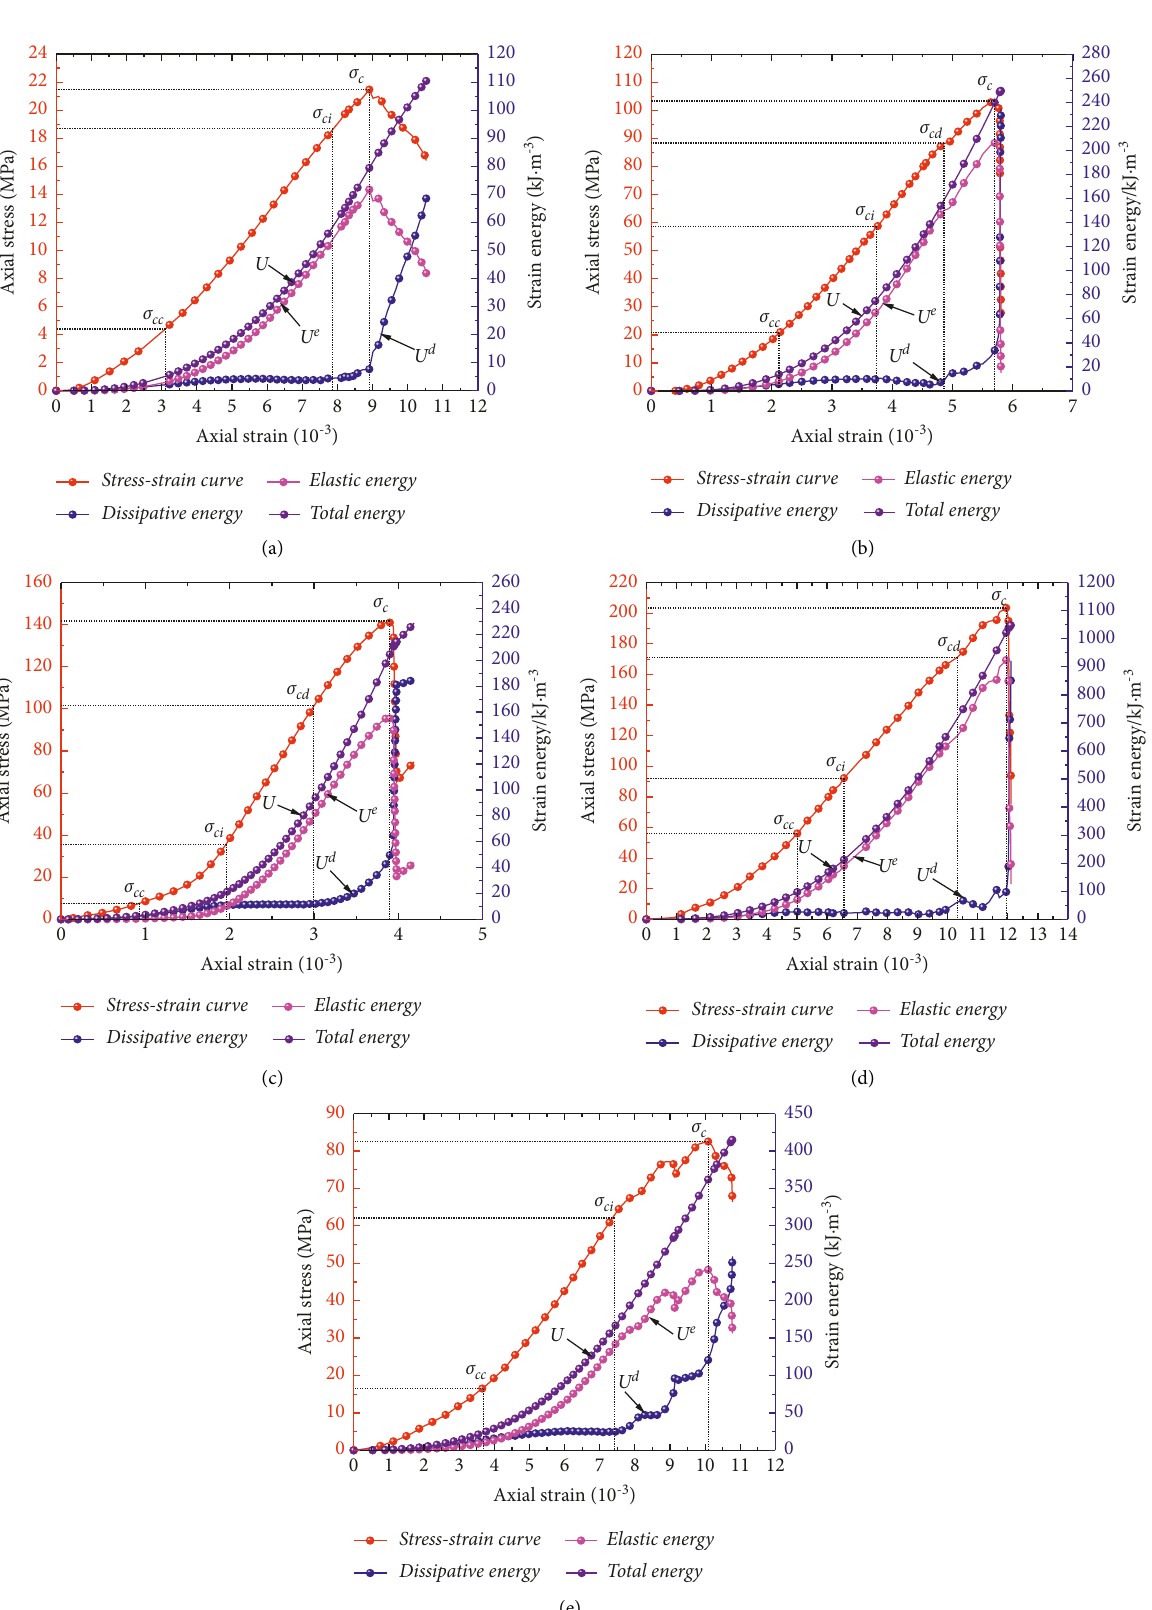
Figure 3: Energy conversion processes under uniaxial load in the different types of rocks. (a) Coal. (b) Granite. (c) Marble. (d) Shale. (e)